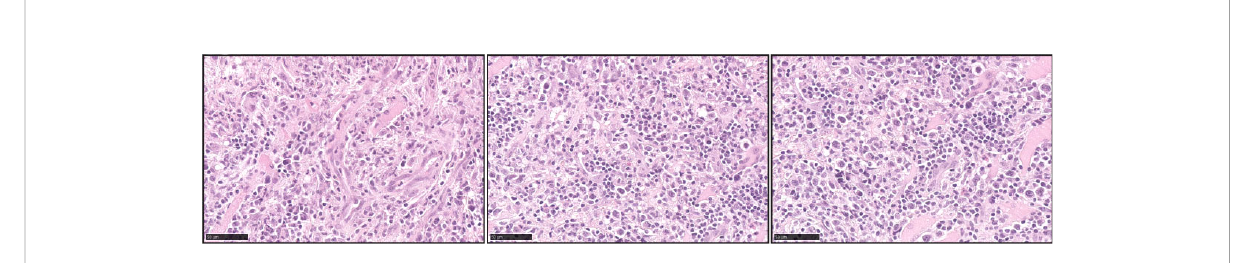
FIGURE 8 Extranodal T/NK-cell lymphoma, nasal type (ENKTL). Three representative pictures of ENTKL (H&E) highlight the pleomorphism of the atypical in fi ltrates. The atypical in fi ltrates can be predominantly composed of small lymphocytes or medium to large atypical forms. Angiocentricity is commonly identi fi